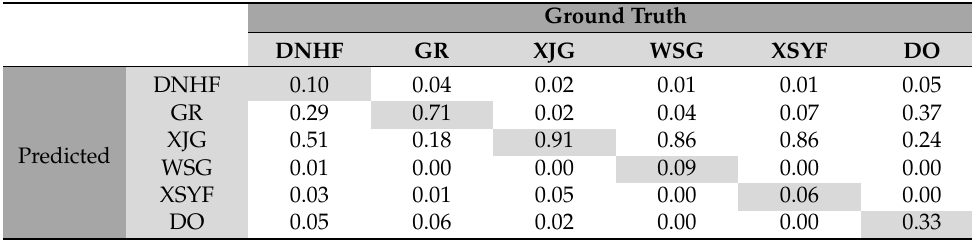
Table 5. The normalized confusion matrix uses the backscatter coefficient and coherence as input features.